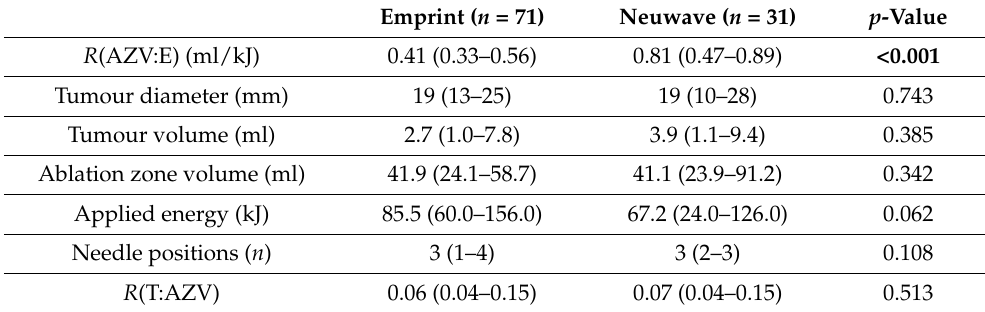
Table 2. Ablation outcome parameters according to ablation device.